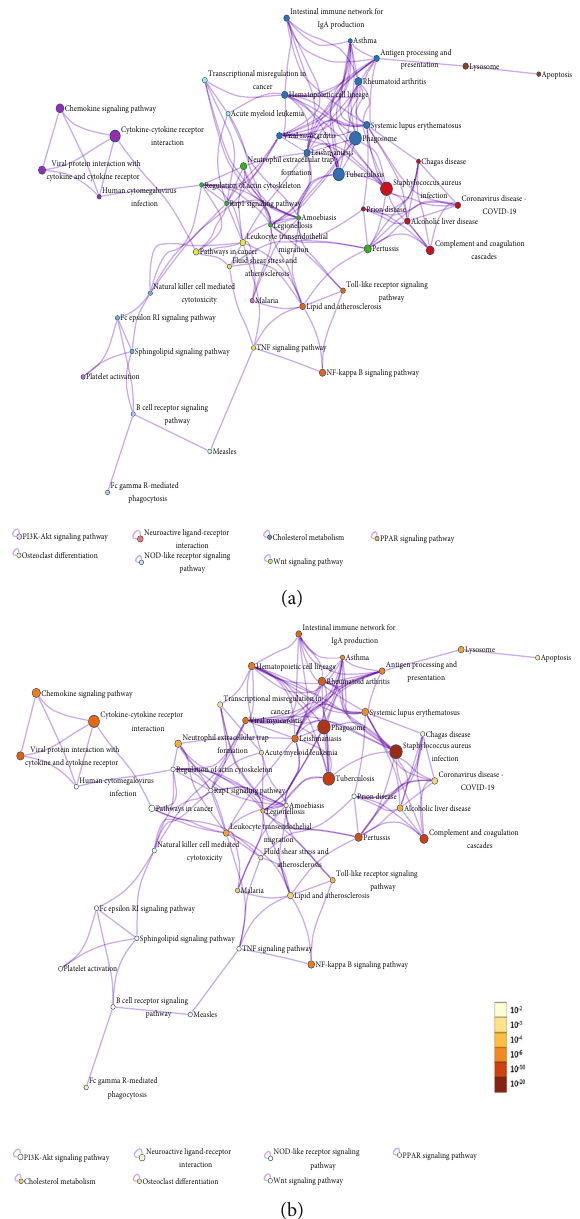
Figure 5: KEGG enrichment analysis of the DEGs in di ff erent biological processes. Figure 5 shows the KEGG pathway enrichment analysis fi ndings. (a) Cluster IDs are color-coded, with nodes that share the same cluster ID being close to each other; (b) P values are colored according to the number of genes they contain, where terms with a higher p-value tend to be more signi fi